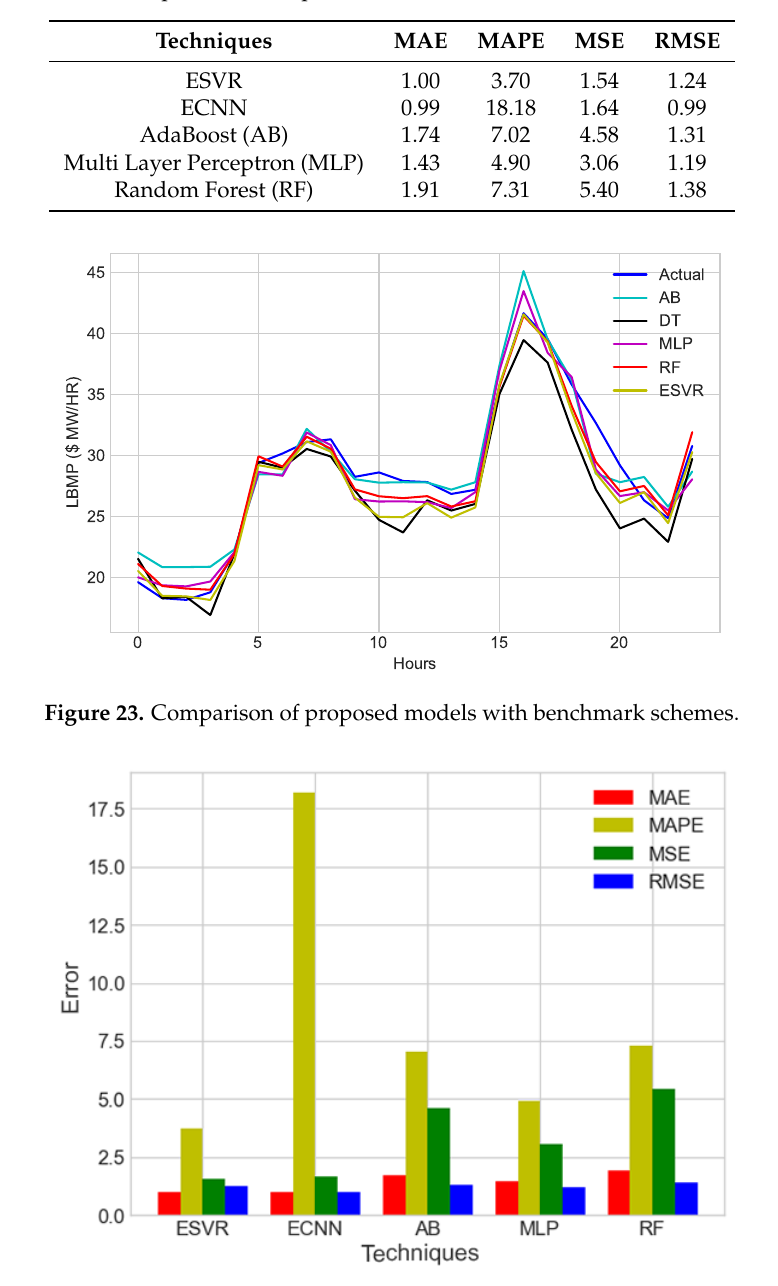
Table 7. Comparison of Proposed Model with other Benchmark Schemes.